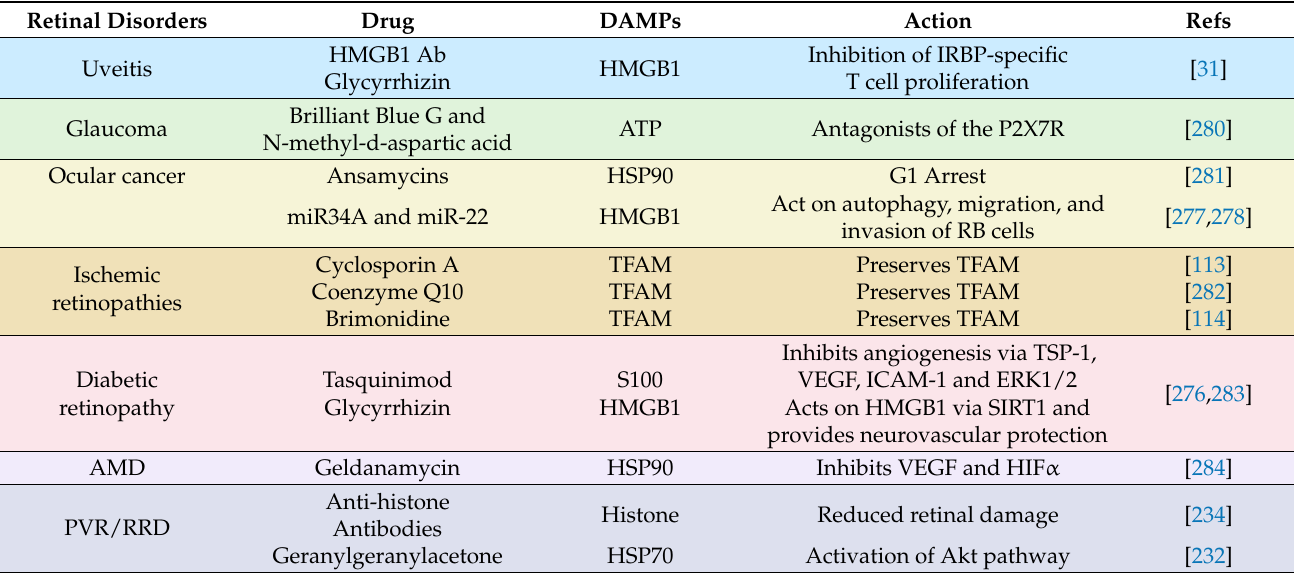
Table 11. DAMPs as therapeutic